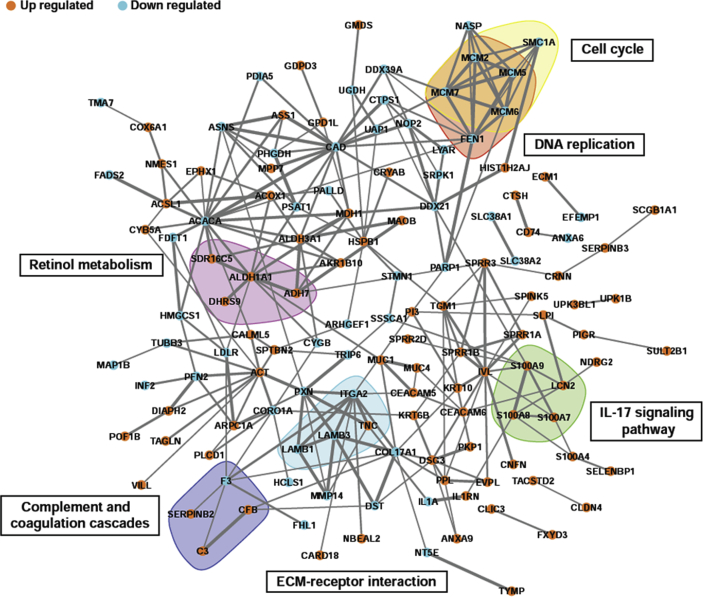
Protein-protein interaction network of up/down regulated proteins in well-differentiated normal human primary bronchial/tracheal epithelial cells compared with un-differentiated cells. Pairs of proteins with interactions are linked with lines. The thickness of the line represents the magnitude of the combined interaction score provided by STRING. Interaction scores ranged between 0.400 and 0.999. Colored blocks were assigned when a minimum of four proteins fell into the same KEGG pathway.